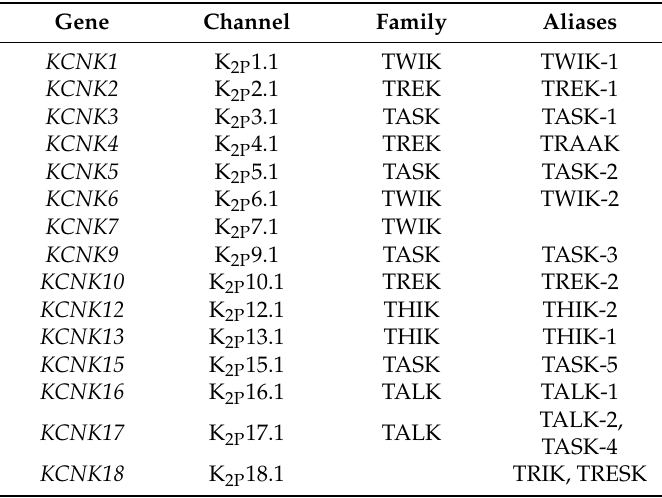
Table 1. Nomenclature of each K 2P channel